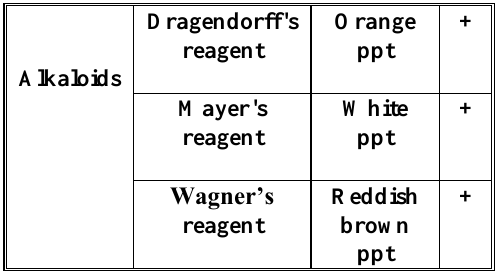
Figure 4. TLC chromatogram of F-1 for Abrus pretacorius plant using silica gel GF 254nm as adsorbent and S2 K [Chloroform: acetone: diethylamine (50: 40:10)] as a mobile phase. Detecting by spraying with dragendorrf's reagent. Std: Abrine standard. Sample: fraction 1